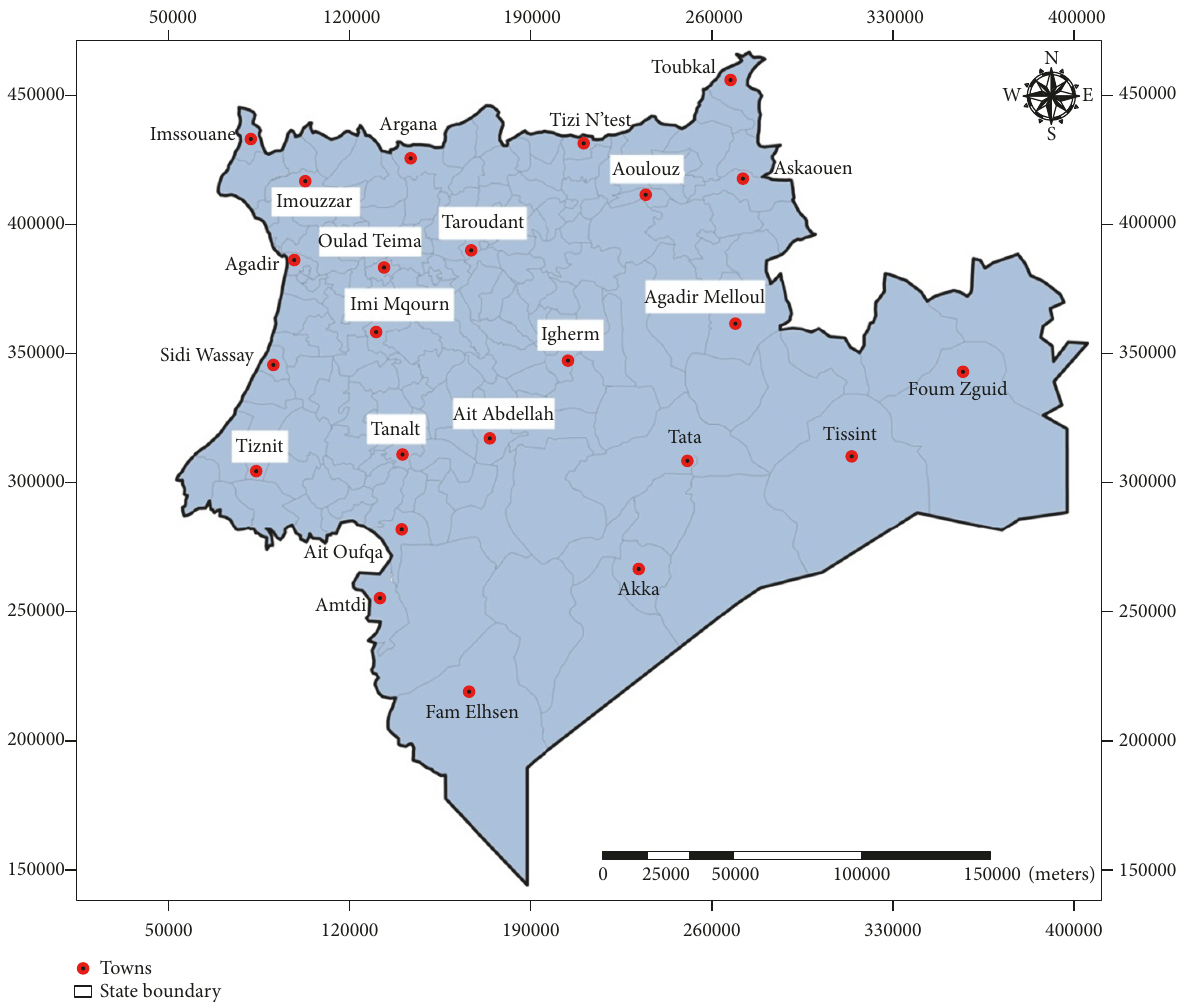
Figure 3: The selected towns used to train and test the